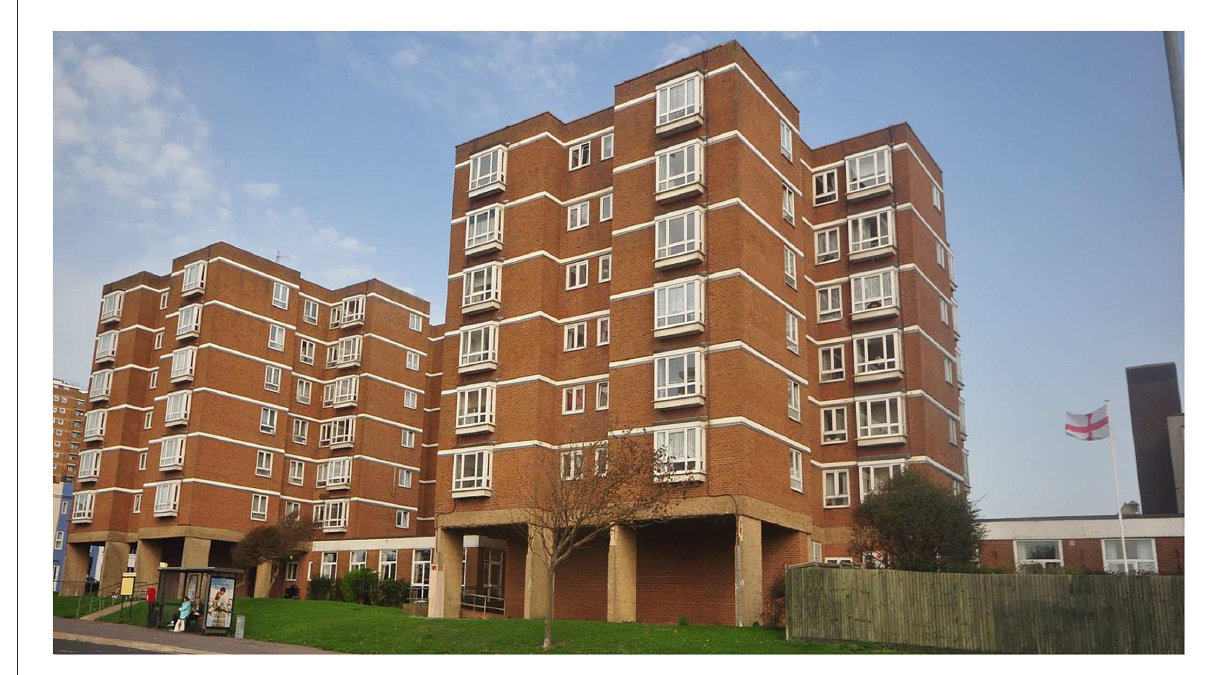
FIGURE1 Digital health living